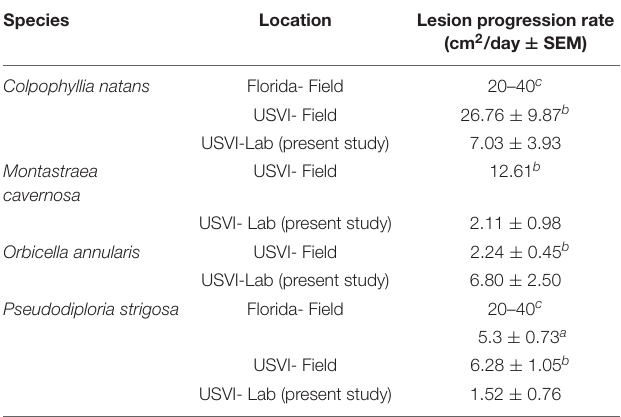
TABLE 1 | Stony coral tissue loss disease (SCTLD) lesion progression rates across regions and studies.